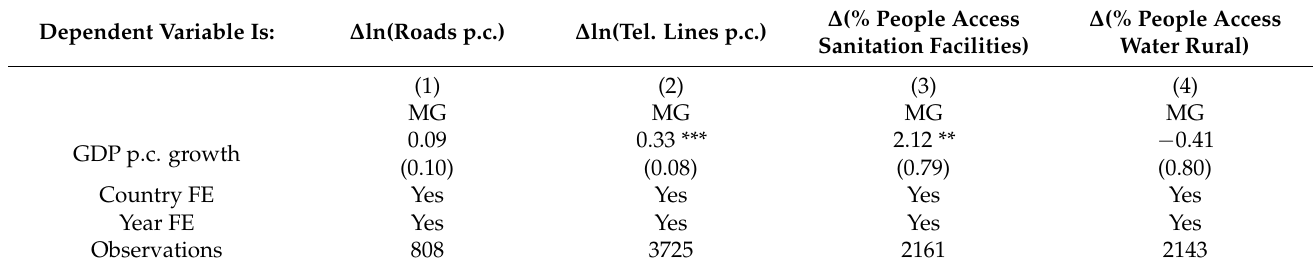
Table A2. GDP growth and infrastructure (mean group